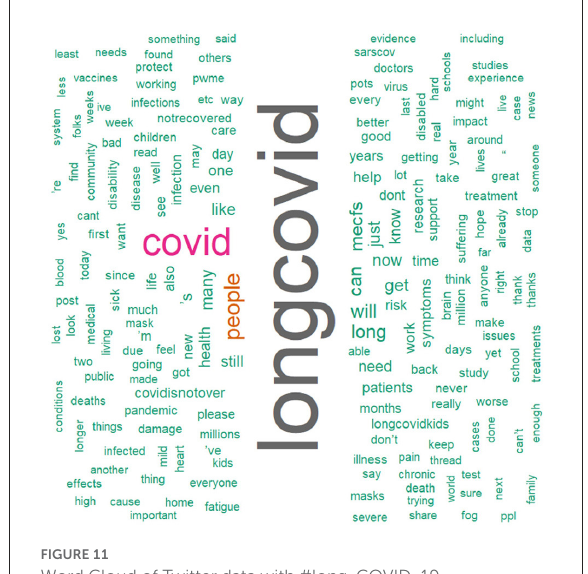
FIGURE11 Word Cloud of Twitter data with